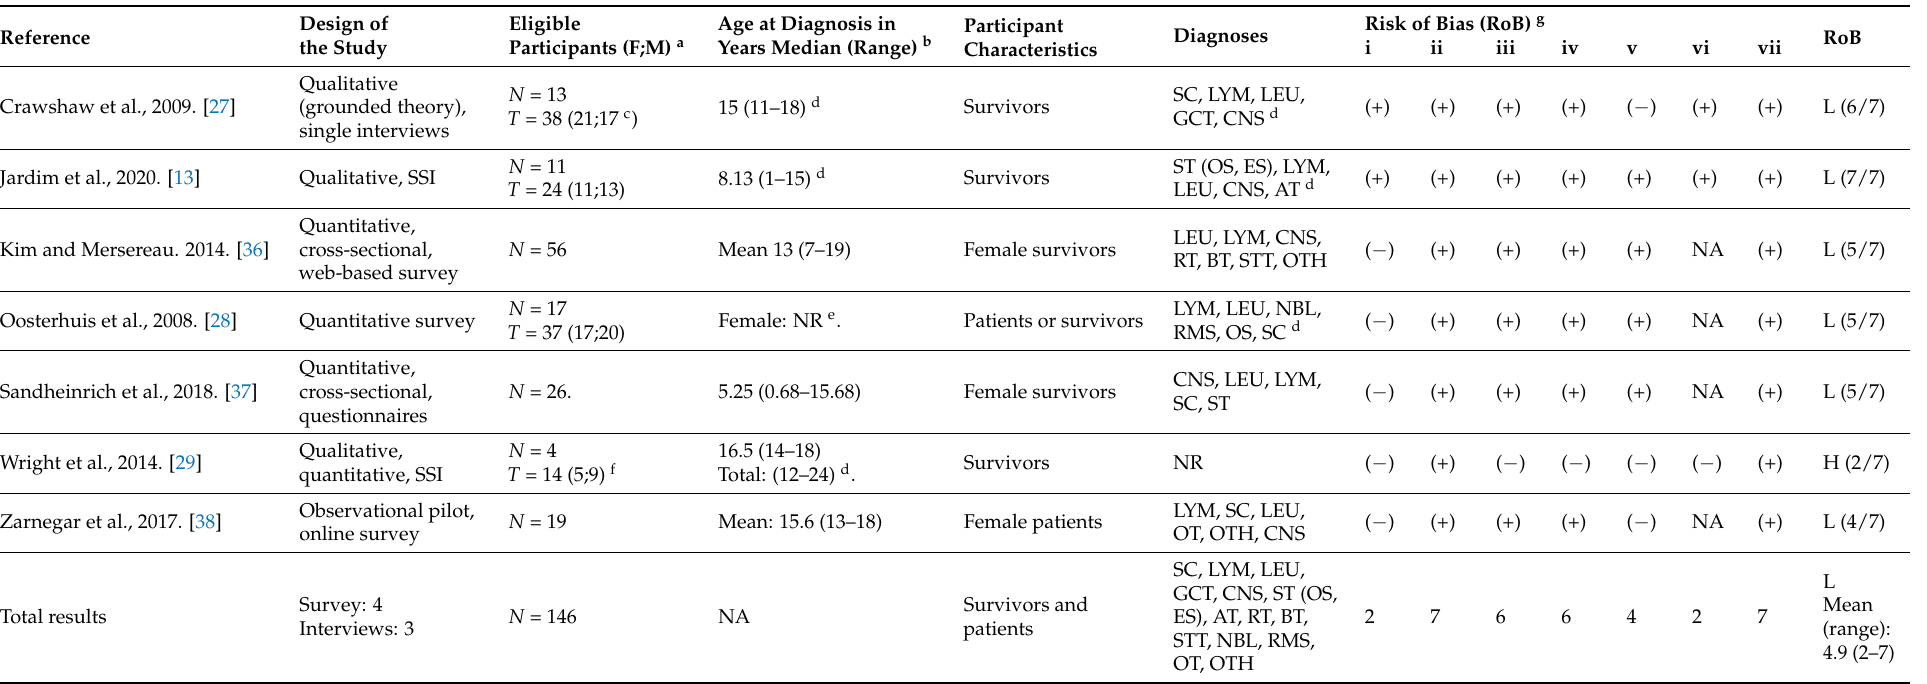
Table 2. Summary of patient characteristics and risk of bias assessment of included